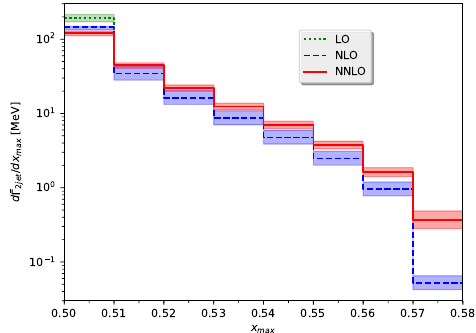
Figure 5 . The distribution of the variable x max de(cid:12)ned in (5.9) for two-jet events using the Durham algorithm with y cut = 0 : 05 at LO (short dashed, green), NLO (long dashed, blue), and NNLO (solid, red) QCD. The central lines correspond to (cid:22) = m h and the shaded bands correspond to scale variations between (cid:22) = m h = 2 and ( (cid:22) = 2 m h